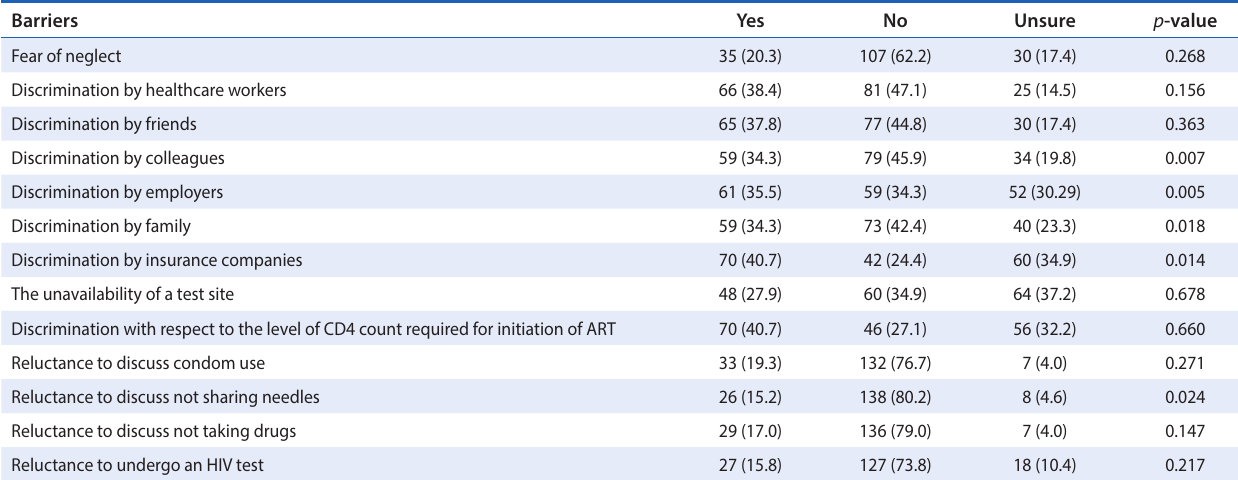
Note: ART: antiretroviral